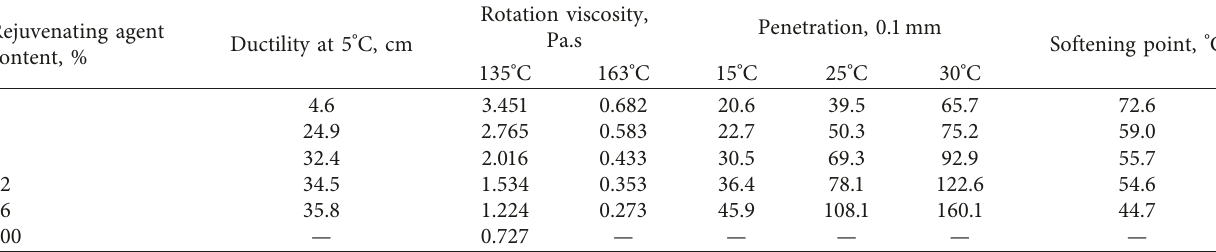
Table 8: Effect of rejuvenating agent content on regenerated asphalt.